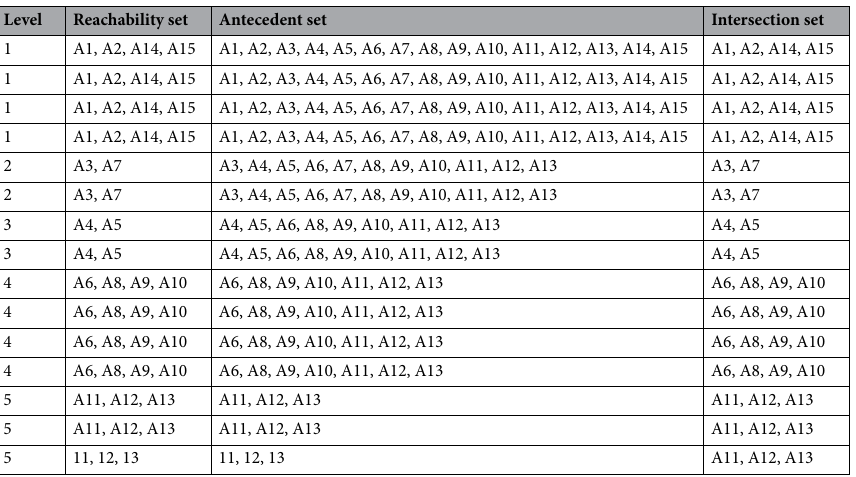
Table 5. Worker productivity and its antecedents.